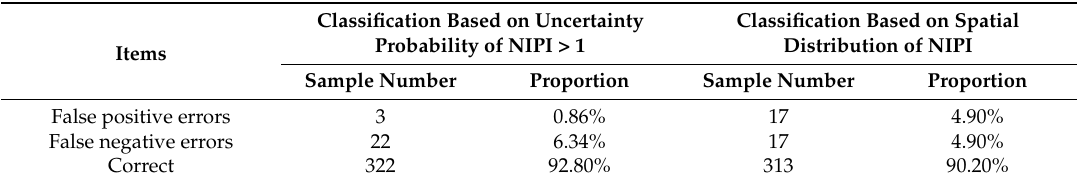
Table 4. Statistics of the delineated area (total validation sample number =